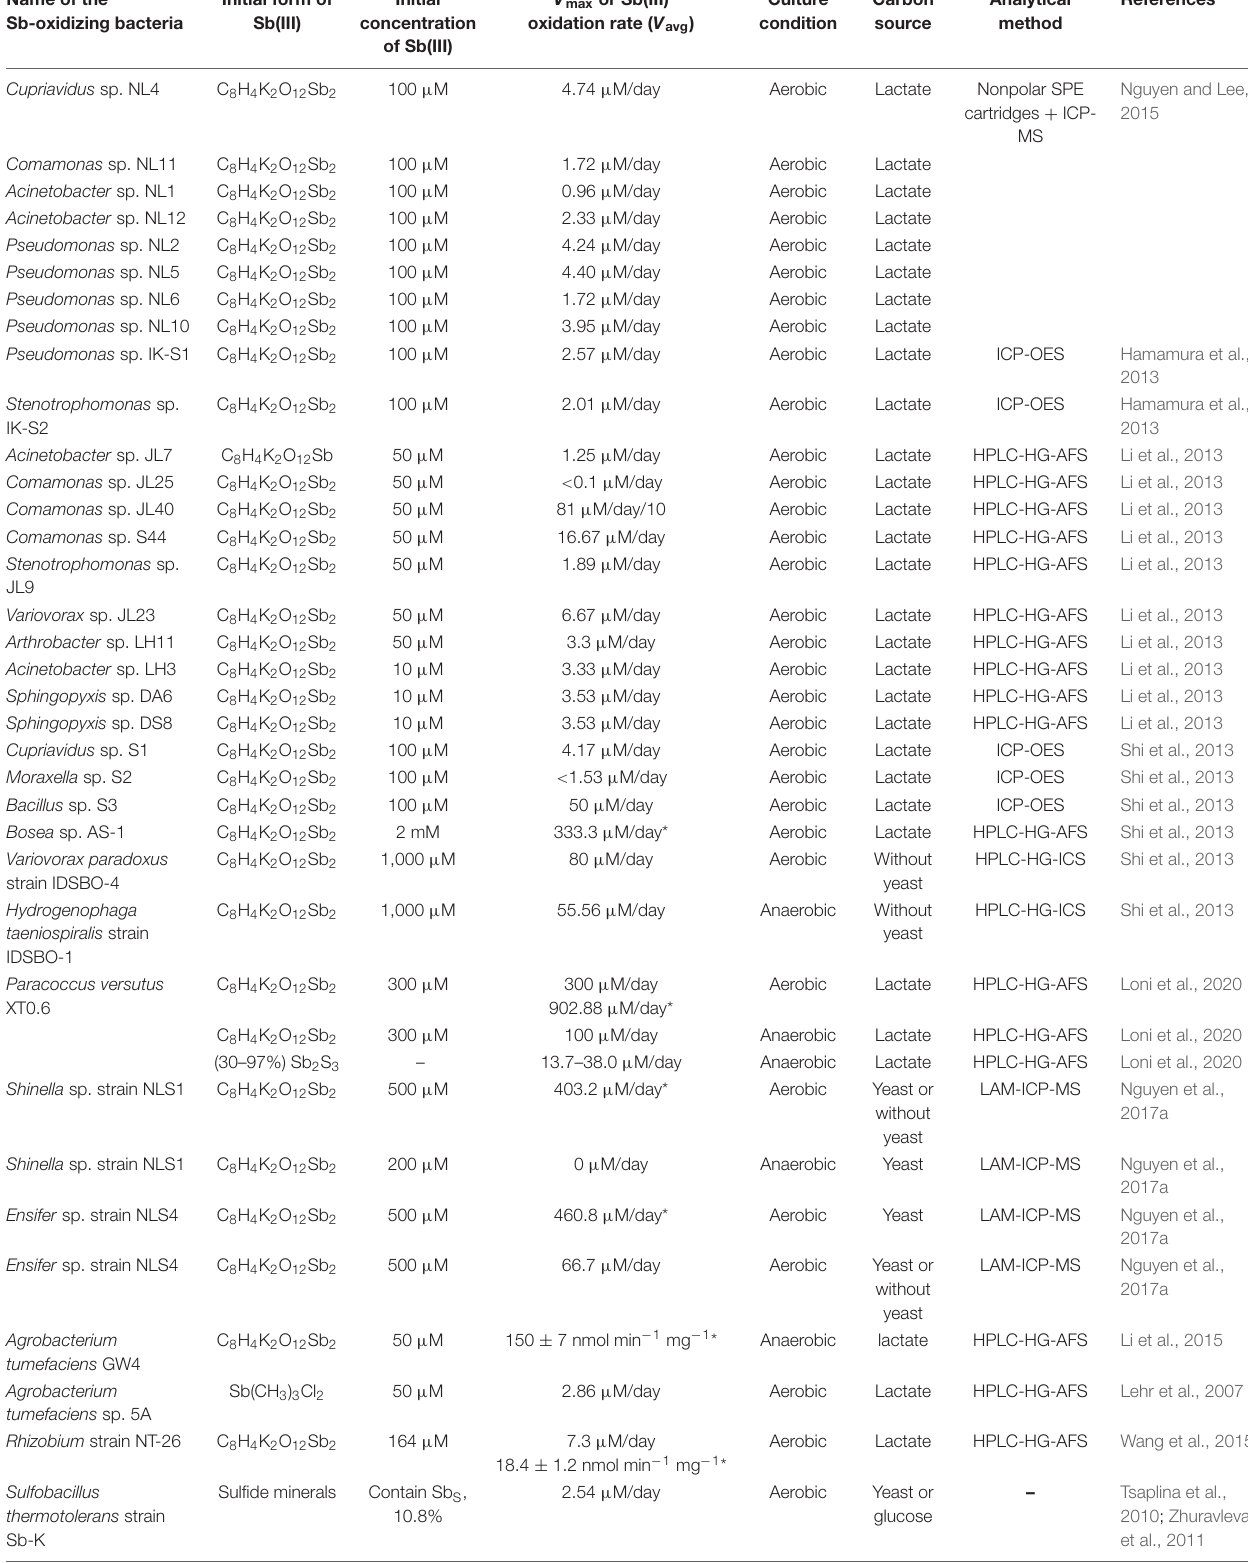
TABLE 1 | Comparison of oxidation rate of Sb(III) for Sb-oxidizing bacteria. Name of the Sb-oxidizing